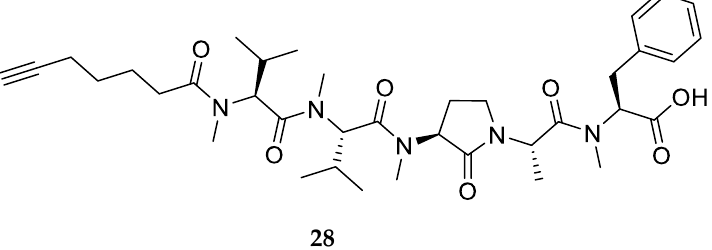
protocol described above for the synthesis of peptide 12 using Fmoc-Agl-Val-OH (462 mg, 3 eq.) in the second coupling, followed by permethylation, peptide 27 (8.3 mg, 3%) was prepared and shown to be >95% pure by LC- MS analysis [50−90% MeOH (0.1% FA) in H 2 O (0.1% FA), 14 min, RT 9.12 min].